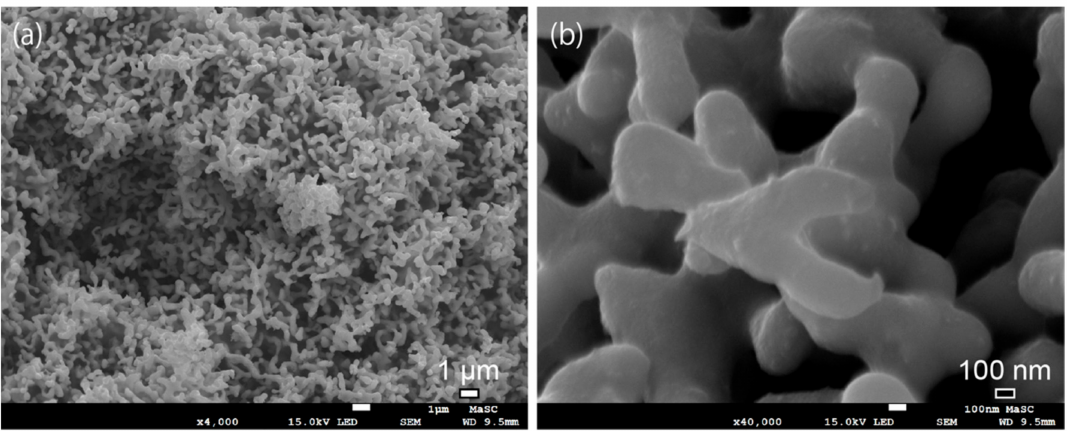
Figure 5. ( a ) Overview and ( b ) close-up images of porous NiMo samples annealed at 950 ◦ C after 2000 CV